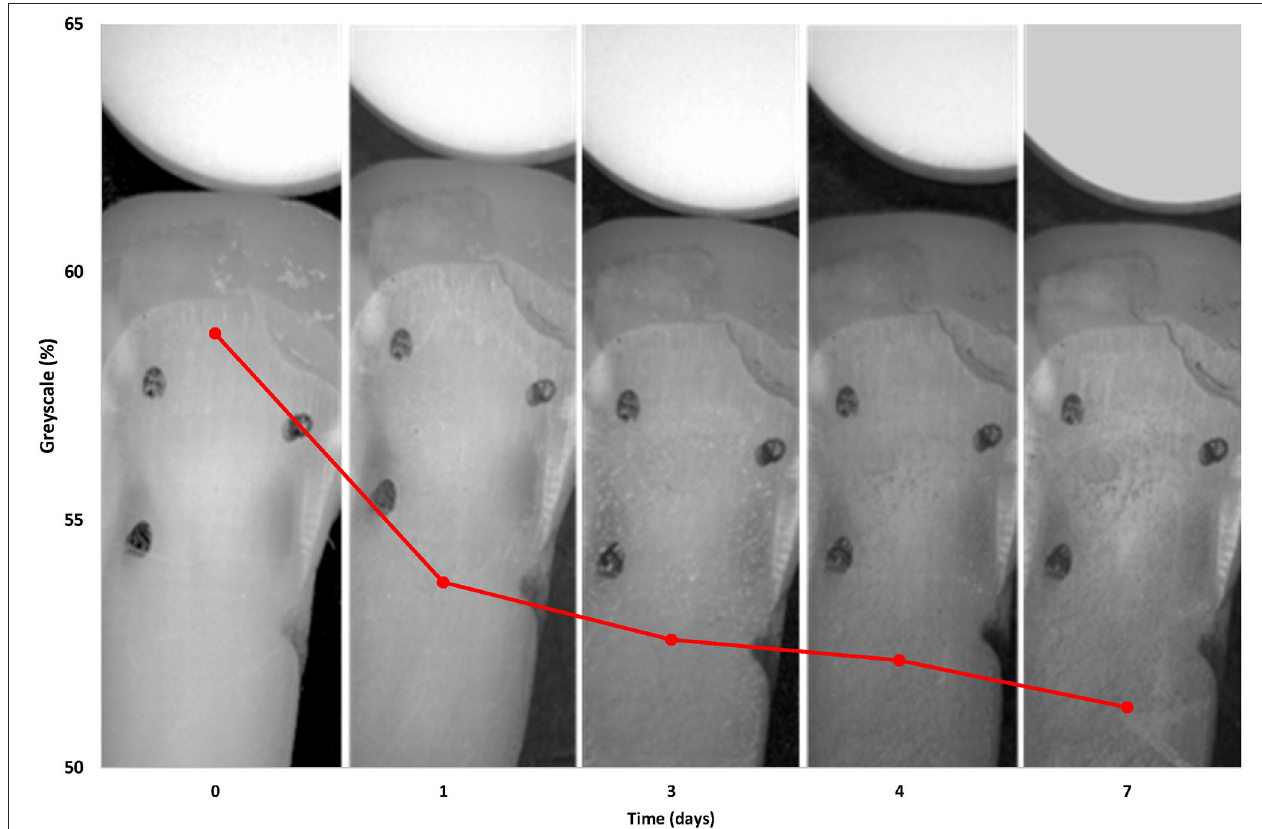
FIGURE 4 | The grayscale % graph of the CHX-tea exposed group overlaid on an image of the dentin tooth samples showing the effect of CHX-tea staining over time.